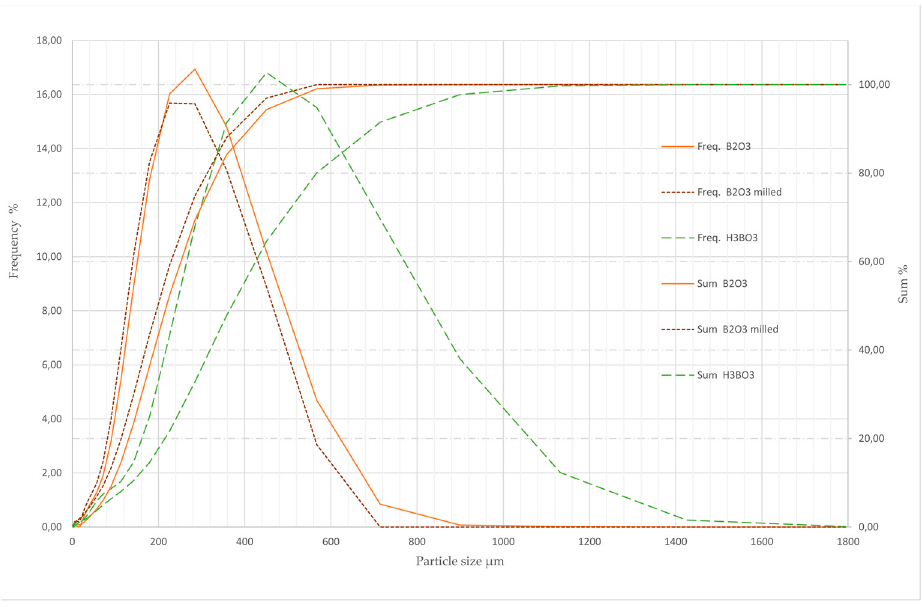
Figure 3. Particle size distribution of B 2 O 3 (before and after milling) and H 3 BO 3 samples.